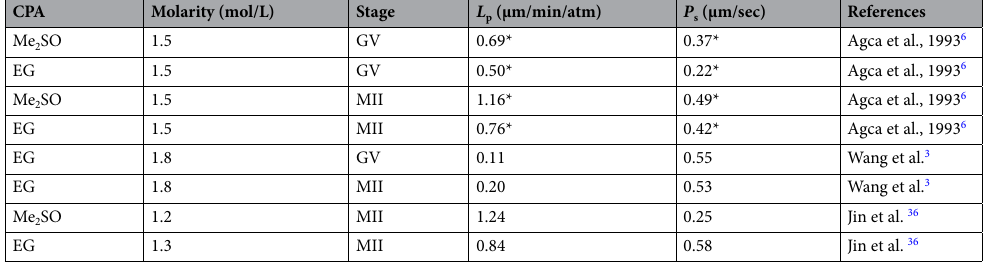
Table 3. Previously determined bovine oocyte plasma membrane water permeability (Lp) and cryoprotectant permeability (Ps) values in the presence of CPA at room temperature. GV, germinal vesicle; MII, metaphase II; EG, ethylene glycol; Me 2 SO, dimethyl sulfoxide. *Published L p and P s values were determined using the Kedem-Katchalsky (KK) model 54 . These KK parameters were converted to the corresponding L p and P s values for the 2P model as described previously 55